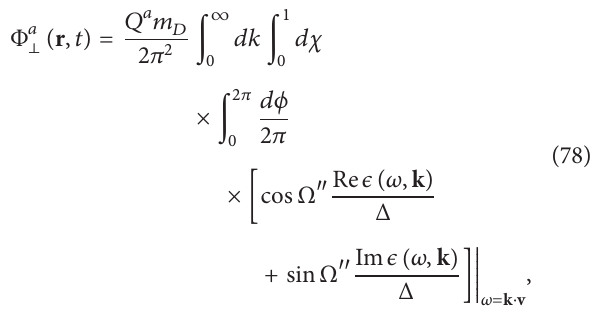
where Ω 󸀠 = 𝑘(𝜌− V 𝑡)√1 − 𝜒 2 cos 𝜙𝑚 𝐷 . For the perpendicular case it is given